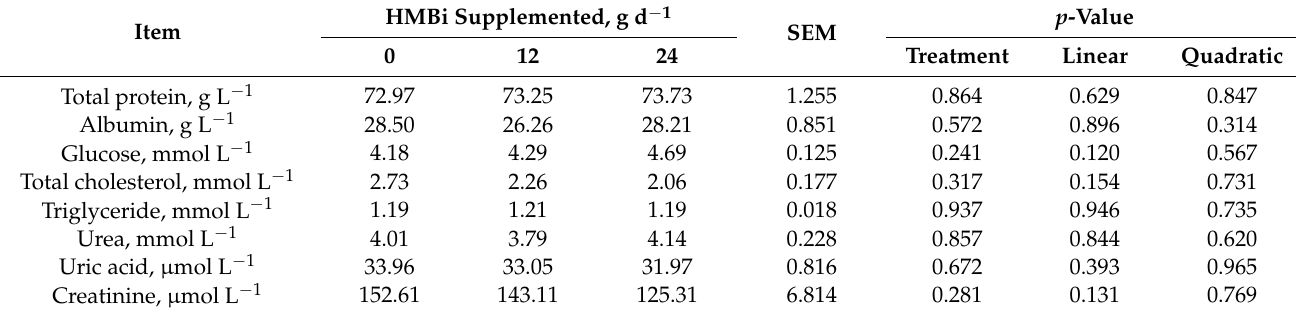
Table 5. Effects of supplementing HMBi on plasma biochemical indices in